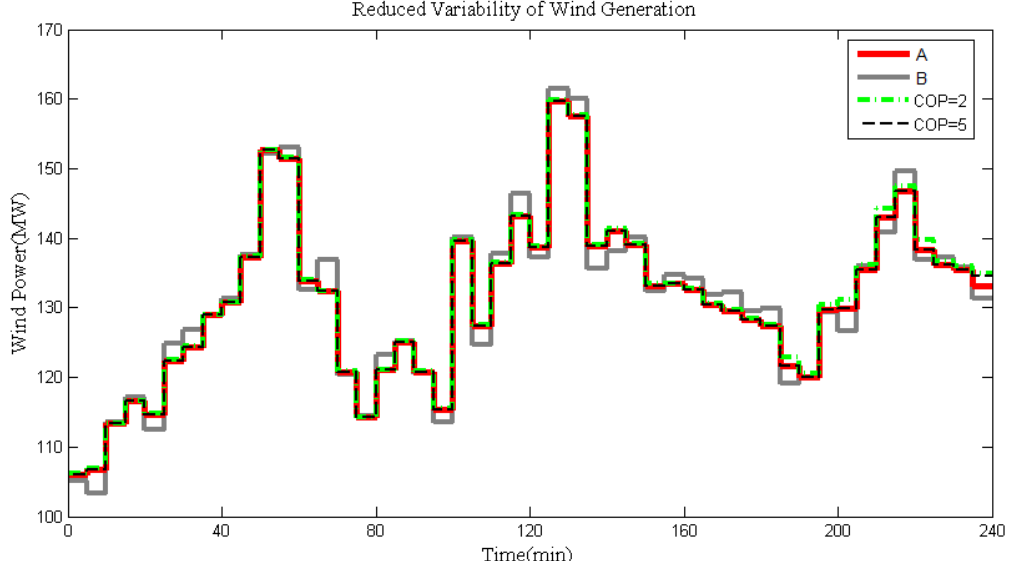
Figure 3. Adjustment of Wind Power (COP =